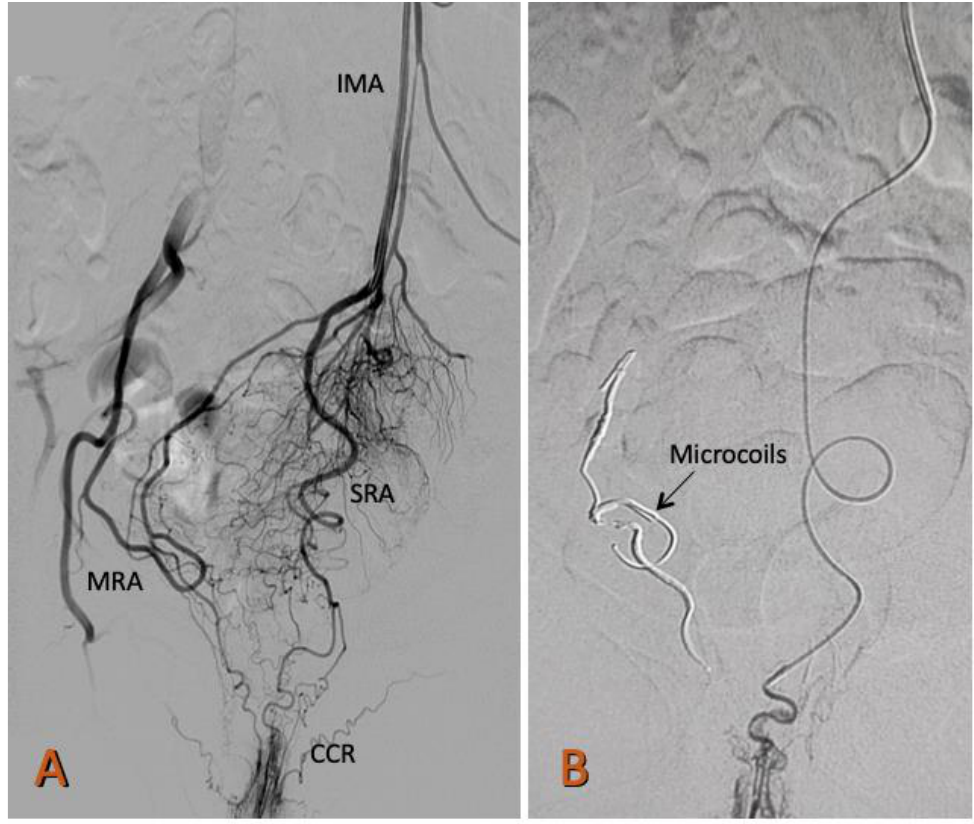
Figure 1. Arteriography of the superior rectal artery (SRA) from the inferior mesenteric artery (IMA). ( A ) The highly developed right branch of the SRA that irrigates the corpus cavernosum rectum CCR is observed. From the origin of the SRA, a collateral arises that anastomoses with the middle rectal artery (MRA), a branch of the right internal iliac artery. The left branch of the SRA is underdeveloped. ( B ) Occlusion with Prestige coils of the right middle rectal artery (MRA) and the right superior rectal artery (SRA).